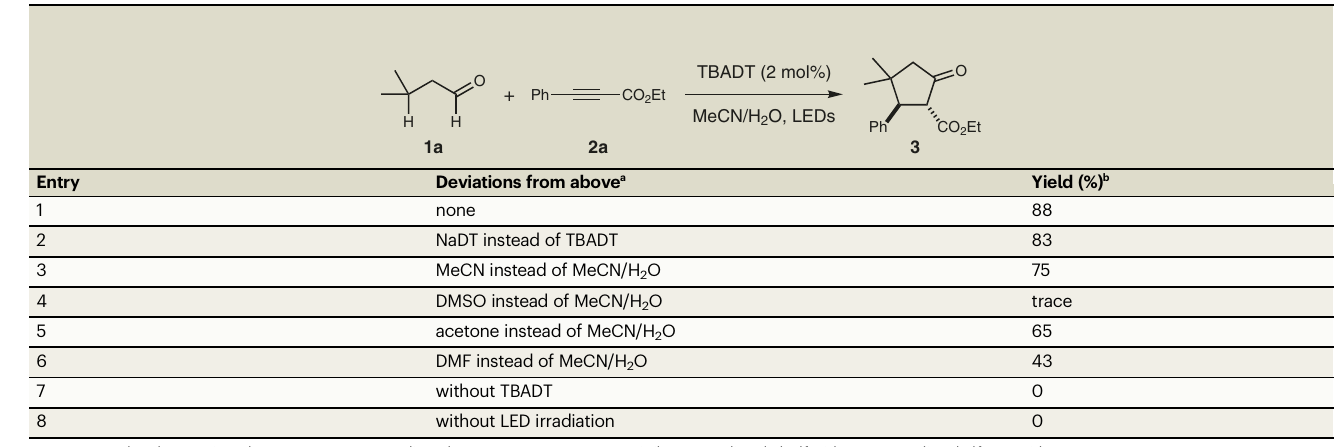
Table 1 | Optimization of reaction